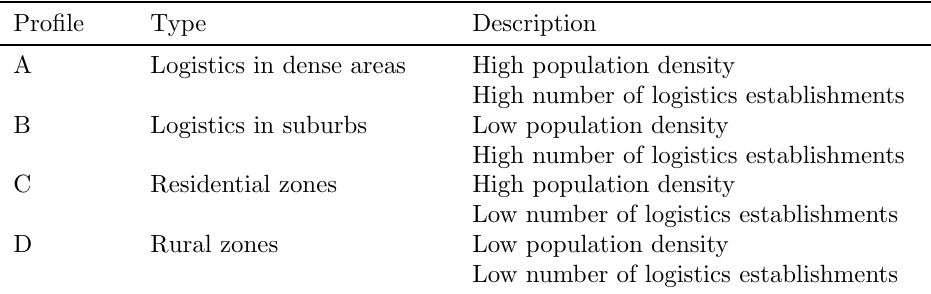
Table 2: Typology of municipality/canton profiles